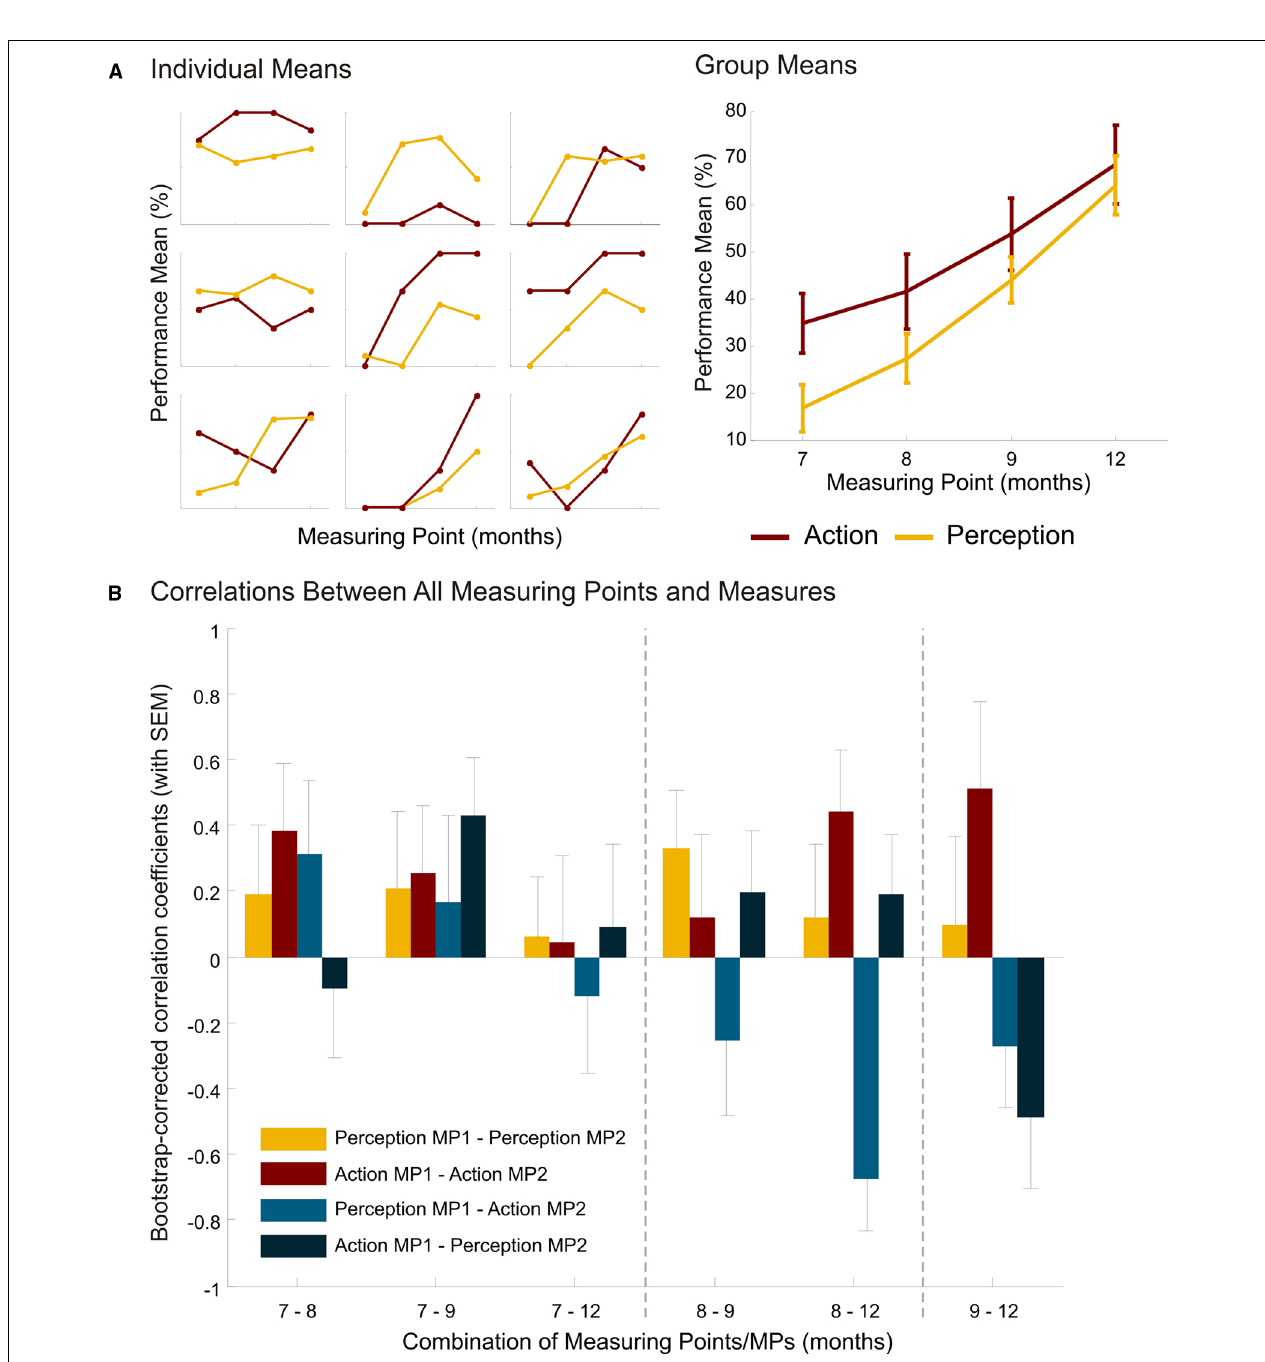
FIGURE 2 | Results. (A) Mean performance for action and perception (in %) of nine individual children and of the group with standard error of the mean at the different measuring points (7, 8, 9, and 12 months of age). Individual data displayed is of the children who provided action and perception measures at all measuring points. Although the number of participants was initially 25, only 18 children participated at age 12 months.